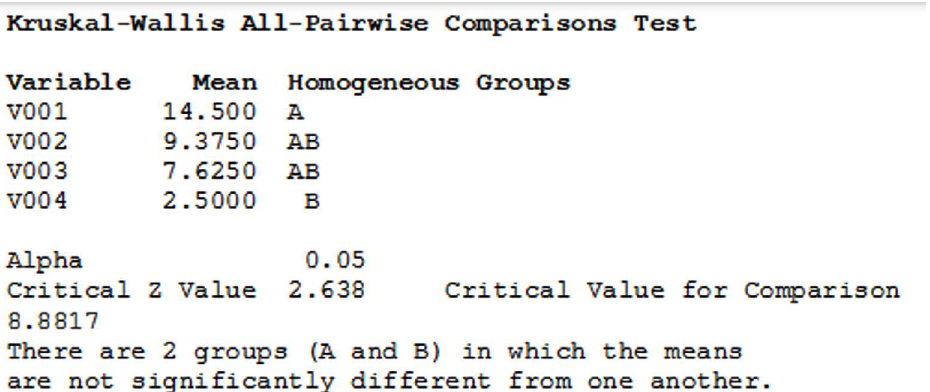
Fig. 5. Kruskal-Wallis All-Pairwise Comparisons Test for the four lotions with Lactobacillus acidophilus ATCC® 4356 against Propionibacterium acnes ATCC®